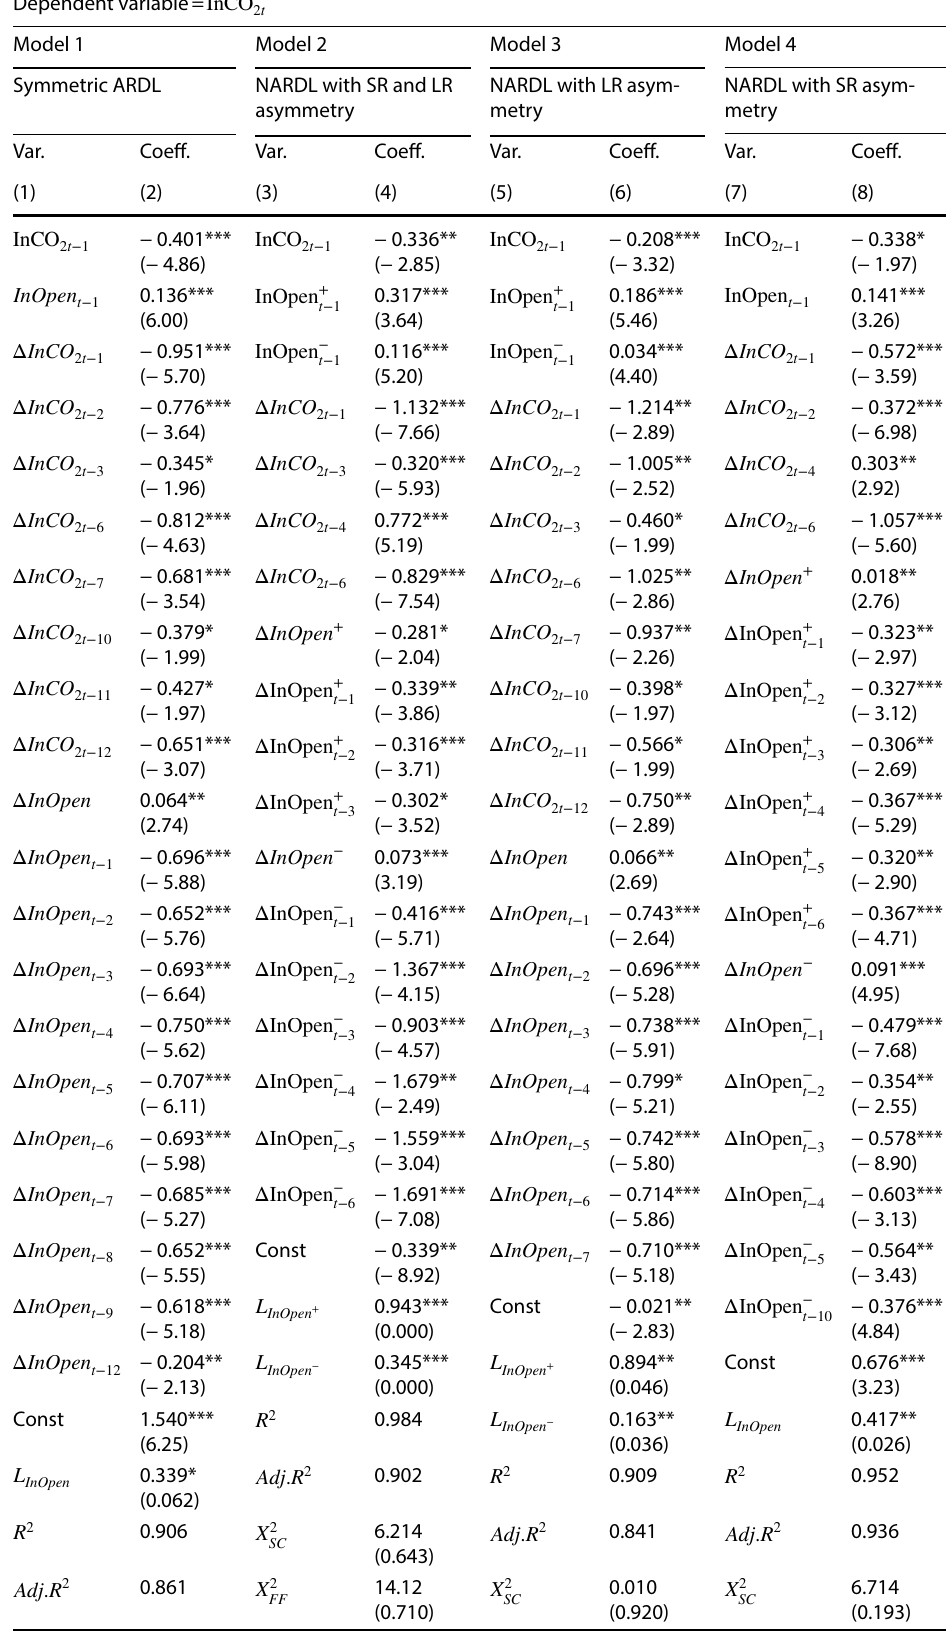
Table 12 Full-information estimates of both symmetric ARDL and nonlinear ARDL (NARDL) models in